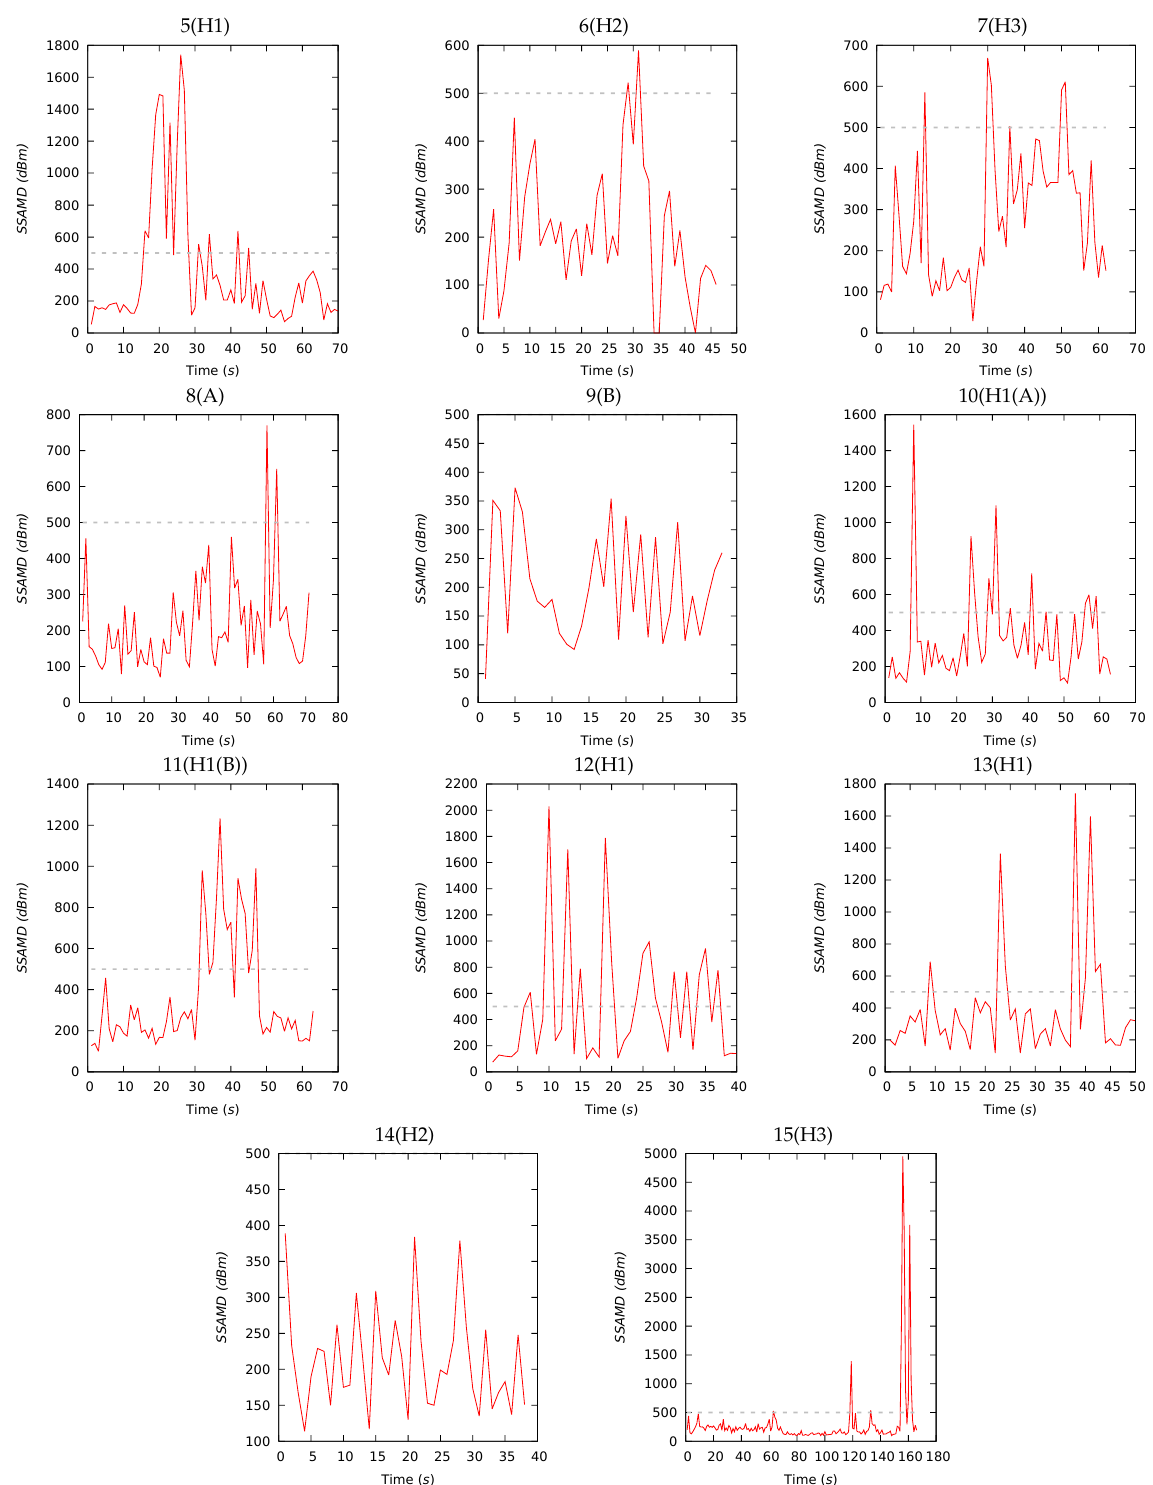
Figure 5. Experiments II. Sialis lutaria , no targets, Acheta domesticus , and Musca domestica . Various height intervals. Trials 8–15 were carried out with the light